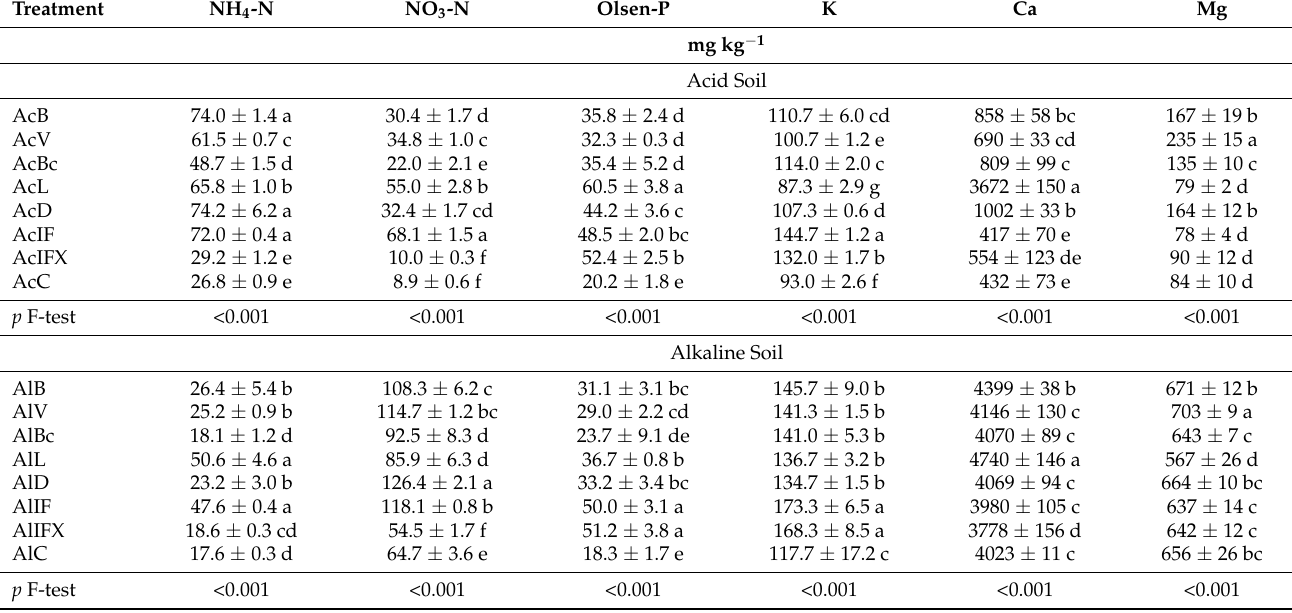
Table 3. Concentrations of available macronutrients of soil treatments before the pot experiment with white clover. Treatment of the acid and alkaline soil, respectively, with: AcB and AlB: bentonite- treated sludge; AcV and AlV: vermiculite-treated sludge; AcBc and AlBc: biochar-treated sludge; AcL and AlL: limed sludge; AcD and AlD: air-dried sludge; AcIF and AlIF: N-P-K inorganic fertilization; AcIFX and AlIFX: P-K inorganic fertilization; AcC and AlC: control. Different letters, within each soil and property, indicate significant differences among means, using the LSD test, at p ≤